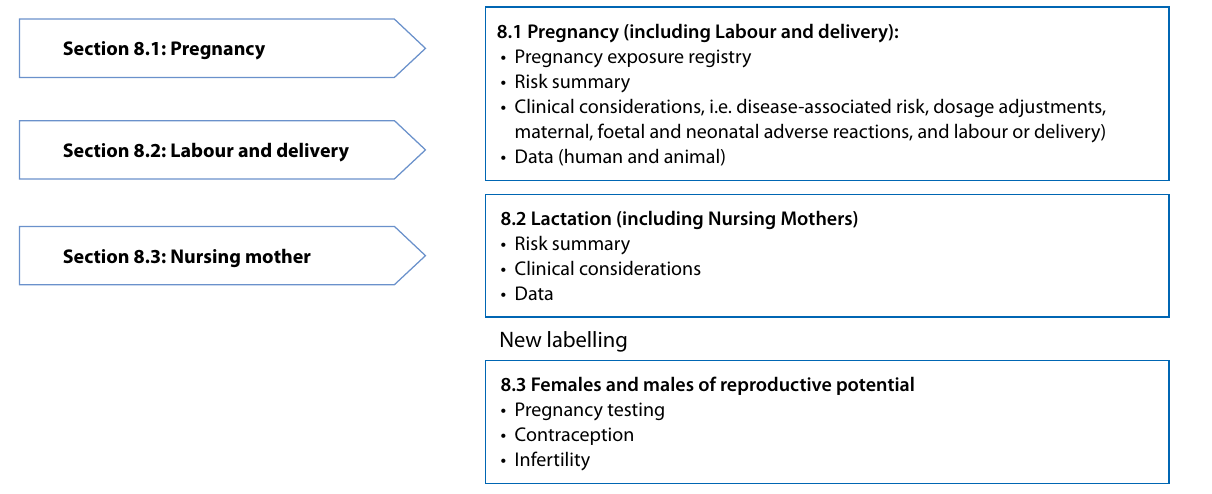
Figure 3: A comparison between the previous prescription drug labelling requirements and the new Pregnancy and Lactation Labeling Final Rule of the US Food and Drug Administration (subsections 8.1–8.3) 11